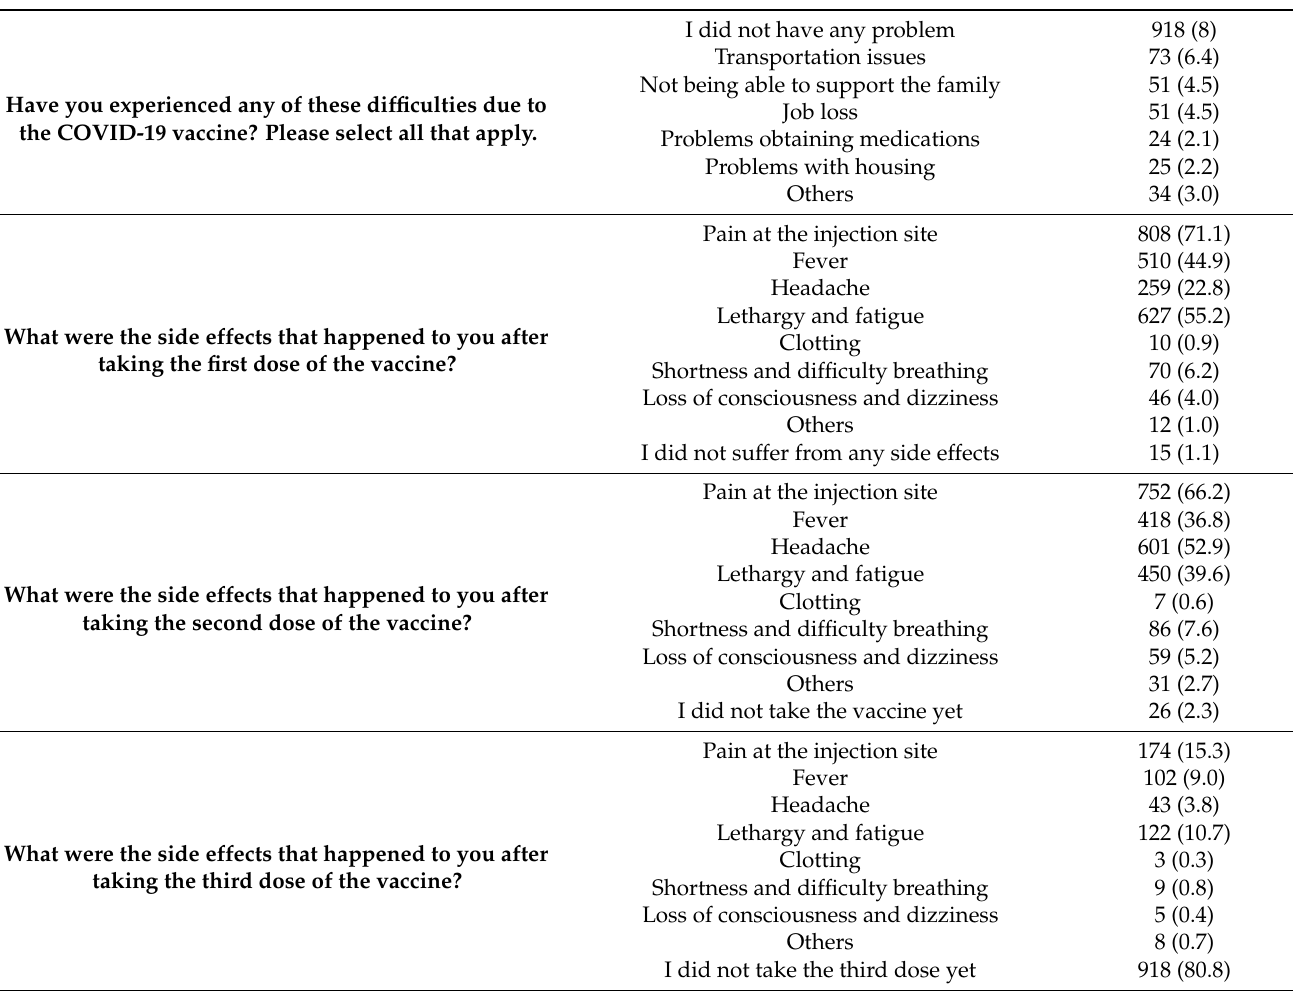
Table 5. Participants’ responses about the adverse effects of COVID-19